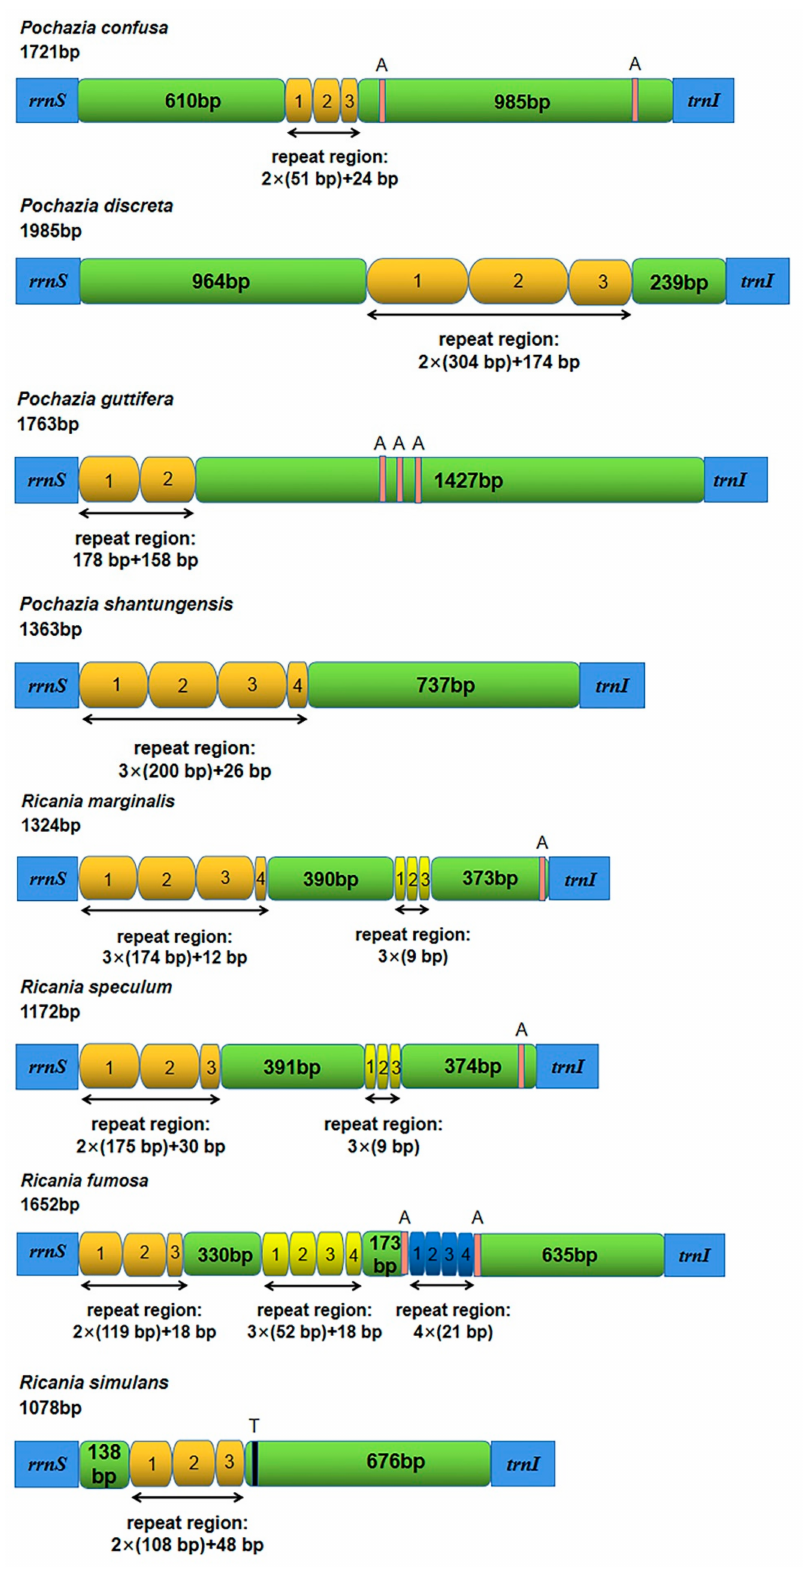
Figure 4. Organization of the control regions in the eight Ricaniidae mitogenomes. The chrome yellow, yellow ochre, and blue rounded rectangles indicate the tandem repeats. Non-repeat regions are represented by a green rounded rectangle. The red and black blocks are the structures of poly (A) or poly